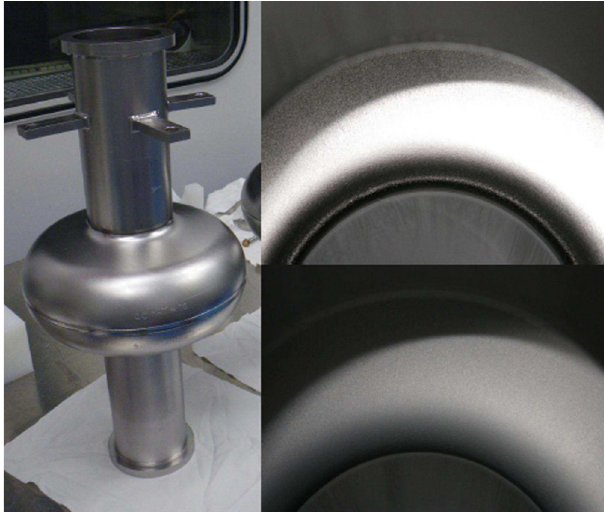
FIG. 4. Coated cavity (left); view looking down into cavity before (top right) and after coating (bottom right).